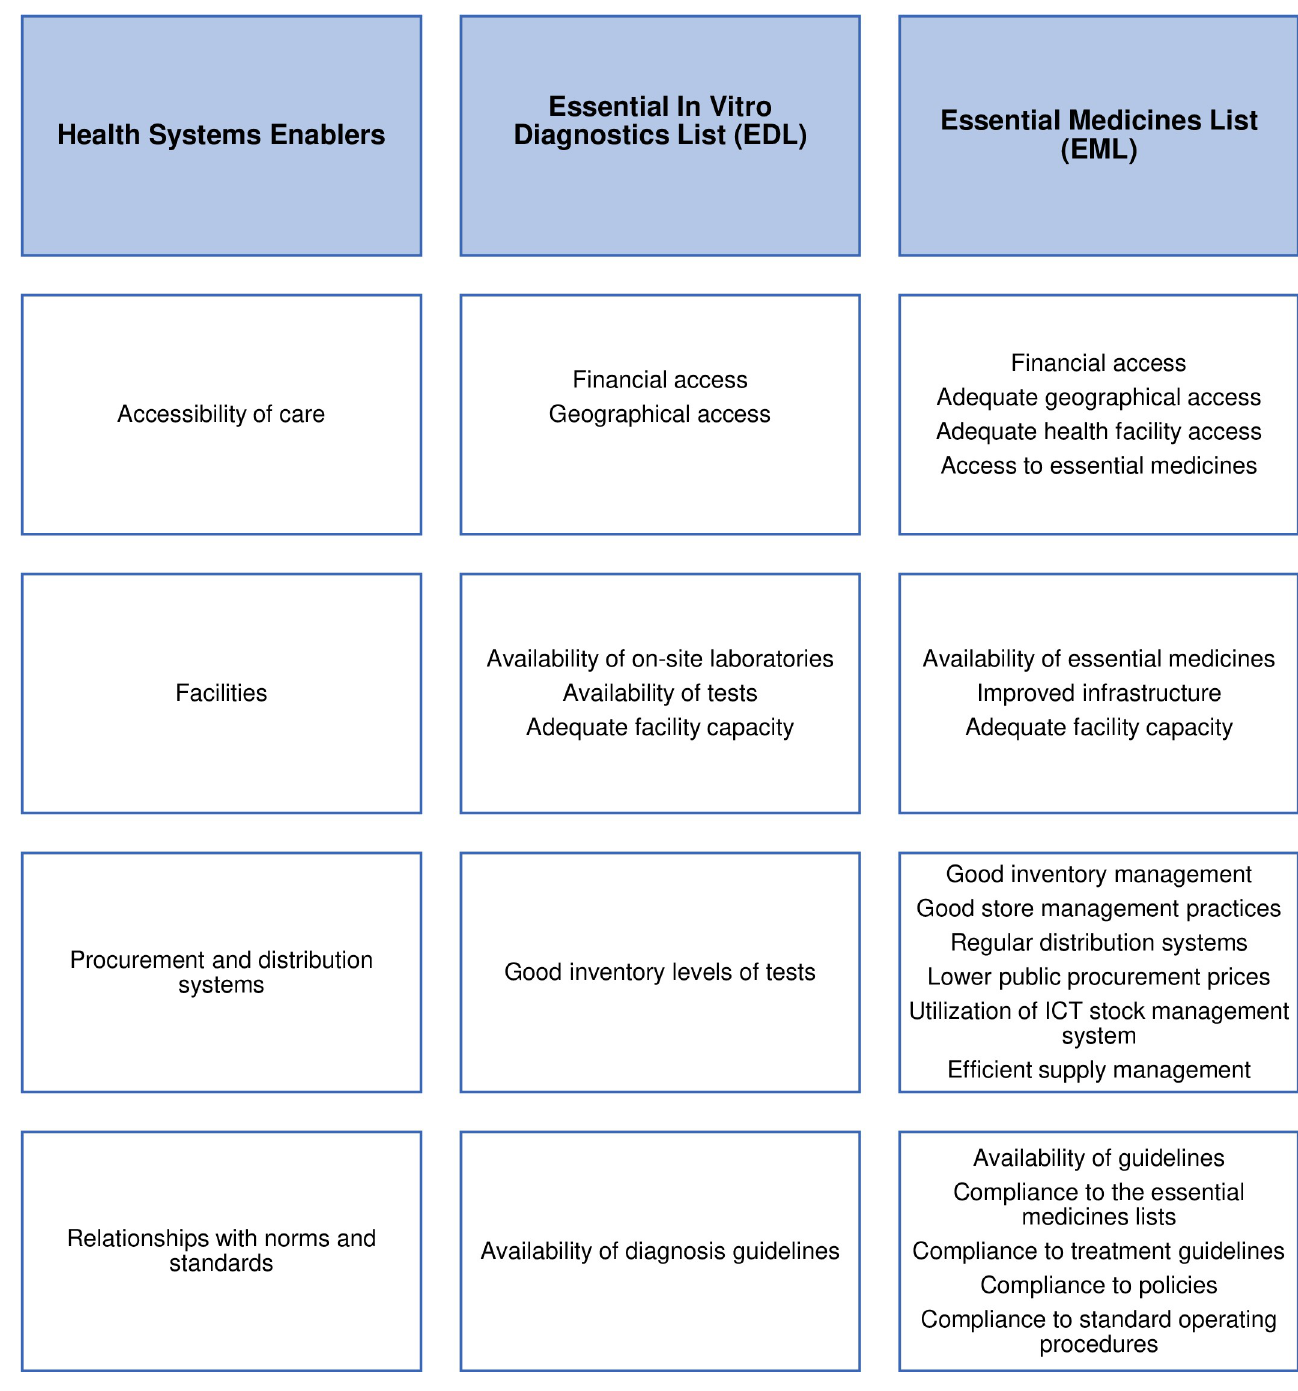
training on current evidence-based treatment [71, 116–119], an insufficient number of skilled healthcare workers [105, 112, 120–122], and inadequate providers’ knowledge of disease man- agement [50, 83, 123]. Other barriers included lack of knowledge of inventory management